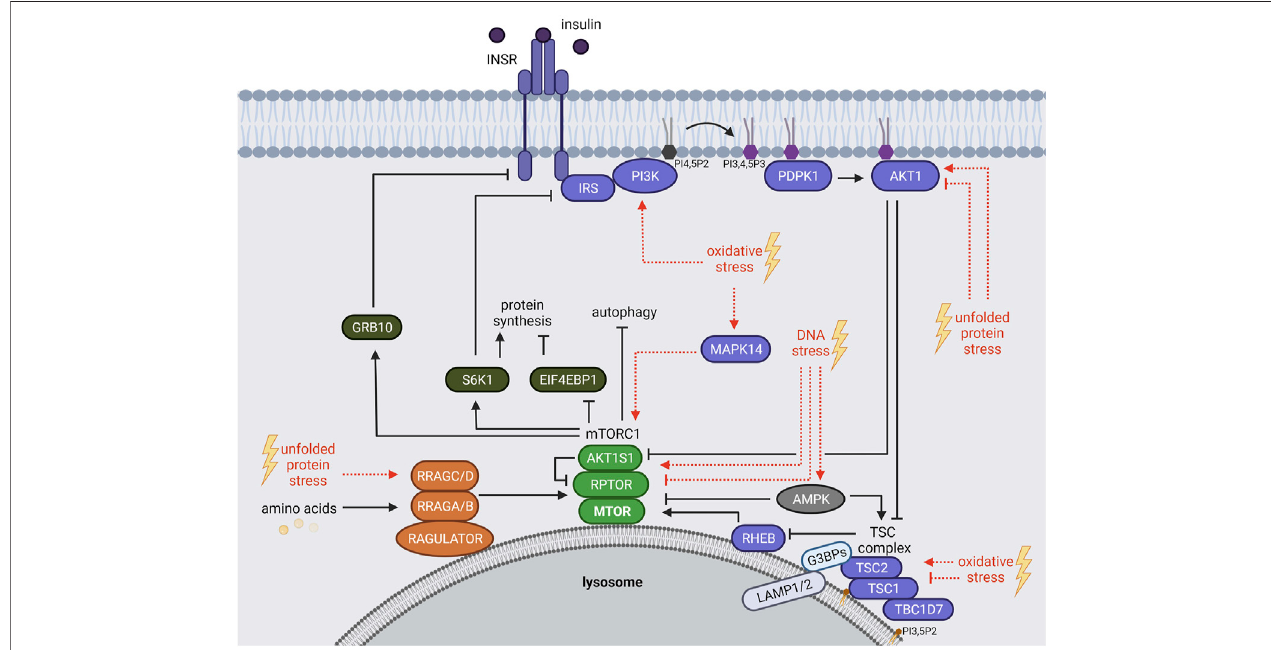
FIGURE 1 | The mTORC1 signaling network. mTORC1 is regulated by growth factors (insulin), amino acids and stressors. Insulin binds and activates the INSR, which recruits IRS and PI3Ks. PI3Ks convert PI4,5P2 to PI3,4,5P3 that serves as an anchor for PDPK1 and AKT1 at the plasma membrane. PDPK1 activates AKT1, which in turn inhibits AKT1S1 and the TSC complex. Hence, TSC-mediated RHEB inhibition is repressed resulting in mTORC1 activation at the lysosome. Amino acids regulate mTORC1 recruitment to the lysosomal surface mainly through the RRAG GTPases. mTORC1 phosphorylates many substrates including EIF4BP1, RPS6KB1 (S6K1) and GRB10. S6K1 and GRB10 mediate negative feedback loops towards the IRS and the INSR, respectively. Age-related stressors (depicted in red) activate or inhibit the mTORC1 network via different mechanisms. See main text for details and abbreviations.